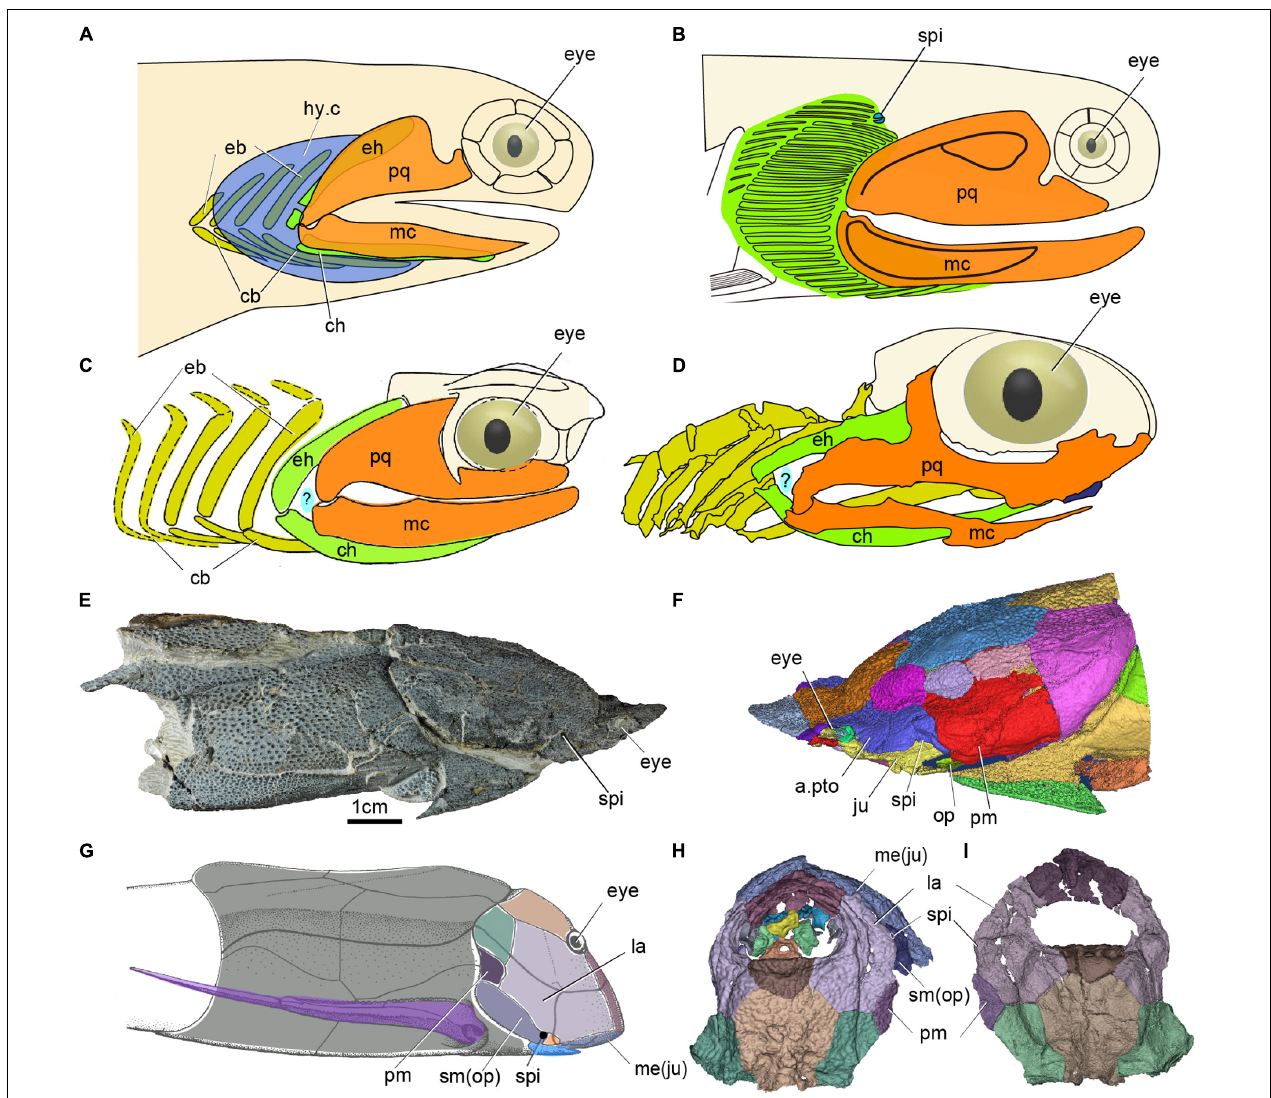
FIGURE 5 | The spiracle in early jawed vertebrates. (A) Head and branchial region of Acanthodes redraw after (DeLaurier, 2018). (B) Head and branchial region of Cheiracanthus showing position of spiracle, redraw after (Burrow et al., 2020). (C) Head and branchial region of Cobelodus , redraw after (Zangerl and Case, 1976). (D) Head and branchial region of Ozarcus , redraw after (Pradel et al., 2014), panels (C,D) showing the possible aphetohyoidean condition, but a respiratory gill pore between its mandibular and hyoid arches is hypothetical (indicated by a question mark). (E,F) Photo (E) and 3D reconstruction (F) of the dermal skeleton of Qilinyu . (G) Dermal skeleton of Bothriolepis redraw after (Arsenault et al., 2004). (H,I) 3D reconstruction of the dermal skeleton of Parayunnanolepis , (E–I) showing a spiracle in placoderms, (A–G) in lateral view, (H) in dorsal view, (I) in ventral view. a.pto, anterior postorbital plate; cb, ceratobranchial; ch, ceratohyal; eb, epibranchial; eh, epihyal; hy.c, hyoid gill cove; hm, hyomandibular; ju, jugal; la, lateral plate; mc, Meckel’s cartilage; me, mental; op, opercular; pm, postmarginal plate; sm, submarginal plate, other abbreviations as in Figures 1 , 2